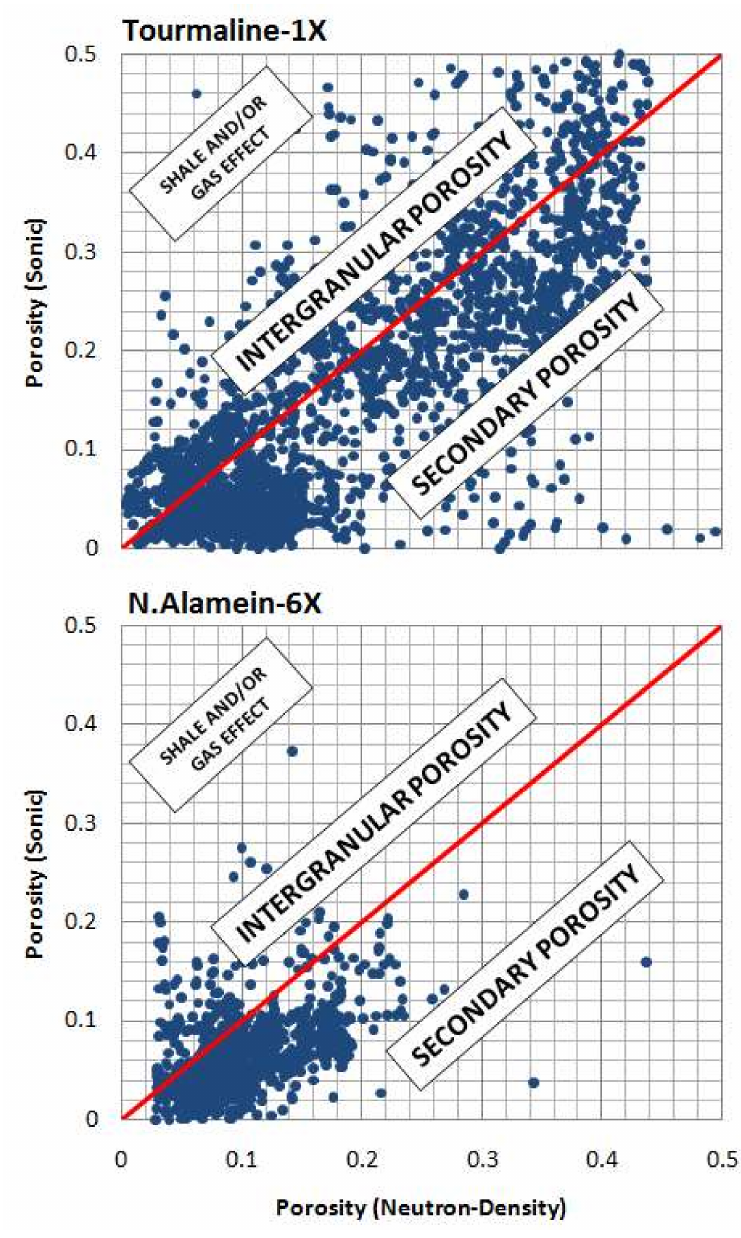
Figure 6. Neutron–density vs. sonic porosity cross-plots for porosity